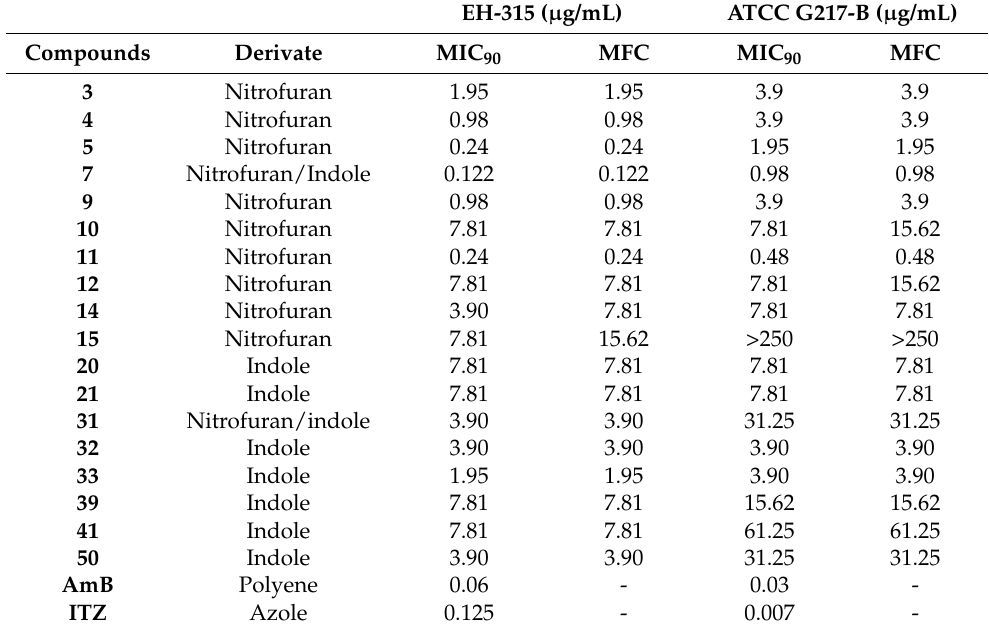
Table 2. MIC 90 and MFC values for H. capsulatum EH-315 and ATCC G217-B strains, for the eighteen most potent compounds in the initial